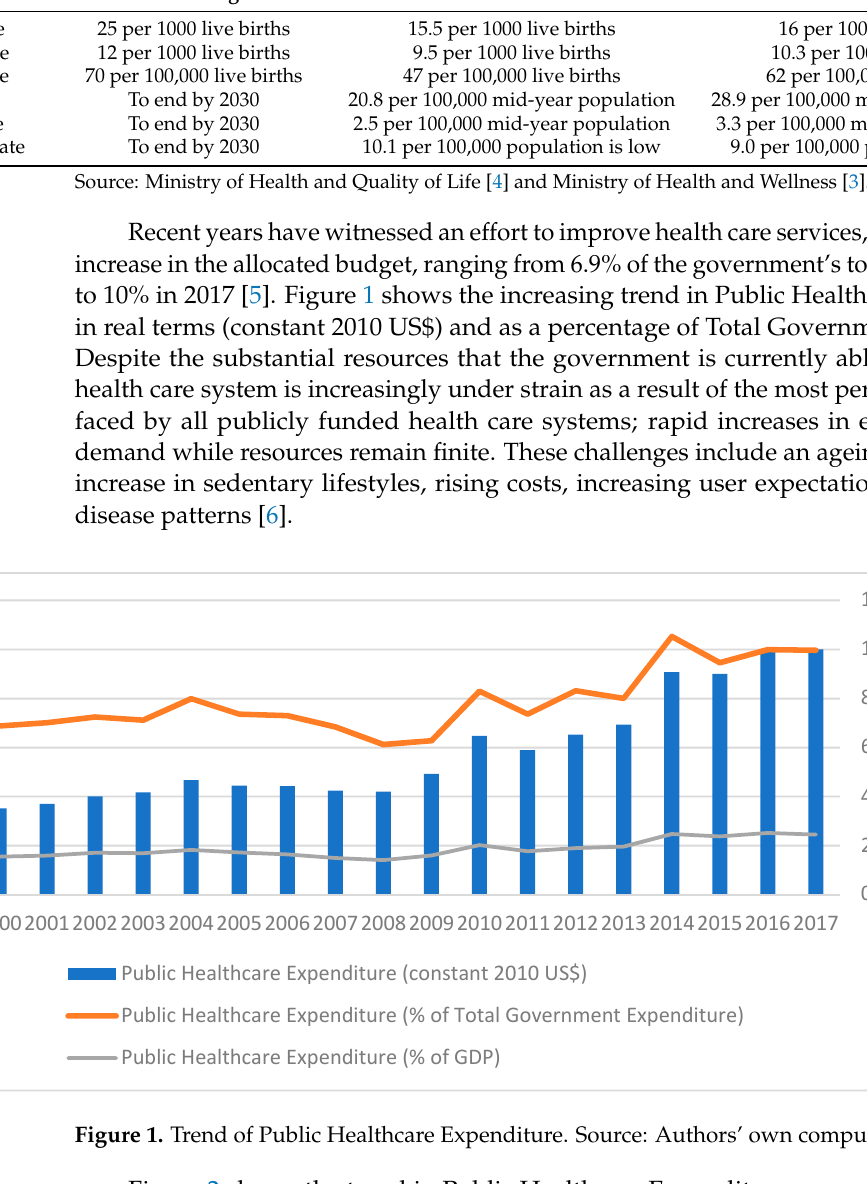
Table 1. Sustainable Development Goals 2030.